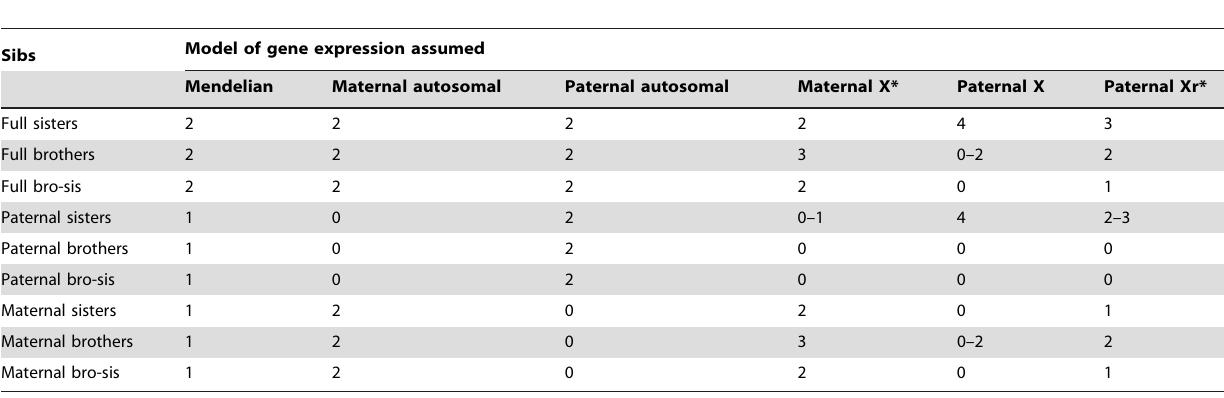
Table 2. Predicted relative order of correlations between siblings by model of preferential gene expression.